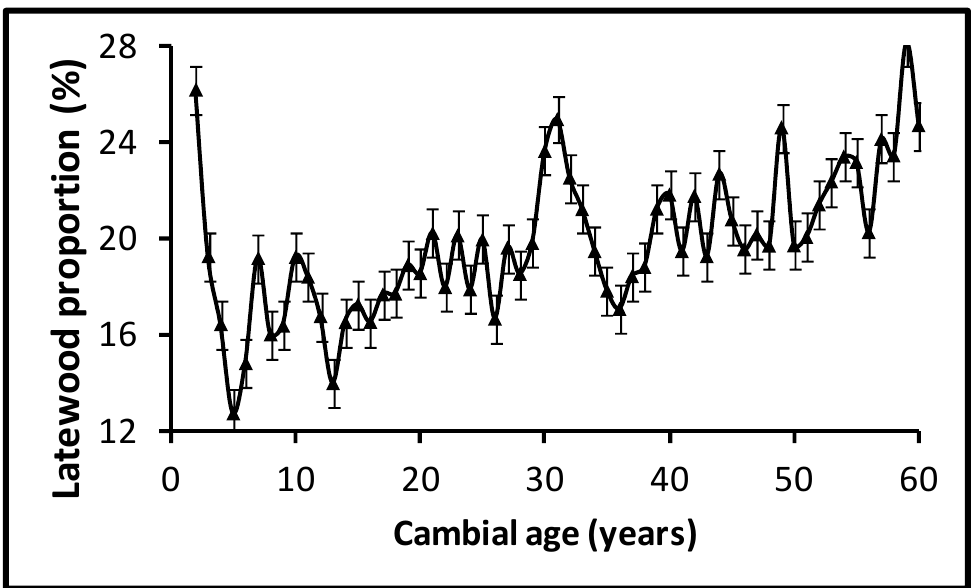
Figure 2. Inter-ring radial variations of latewood proportion (LWP). Bars indicate standard errors of the mean.